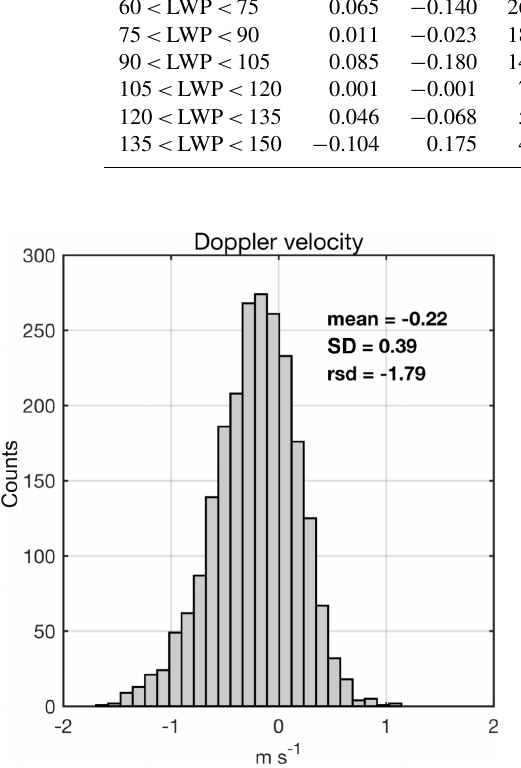
Figure 2. Histograms of the Doppler velocity for the aggregated data